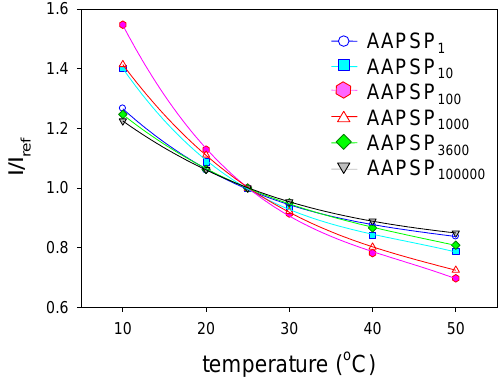
Figure 2. Temperature calibrations of AA-PSPs with varying the dipping